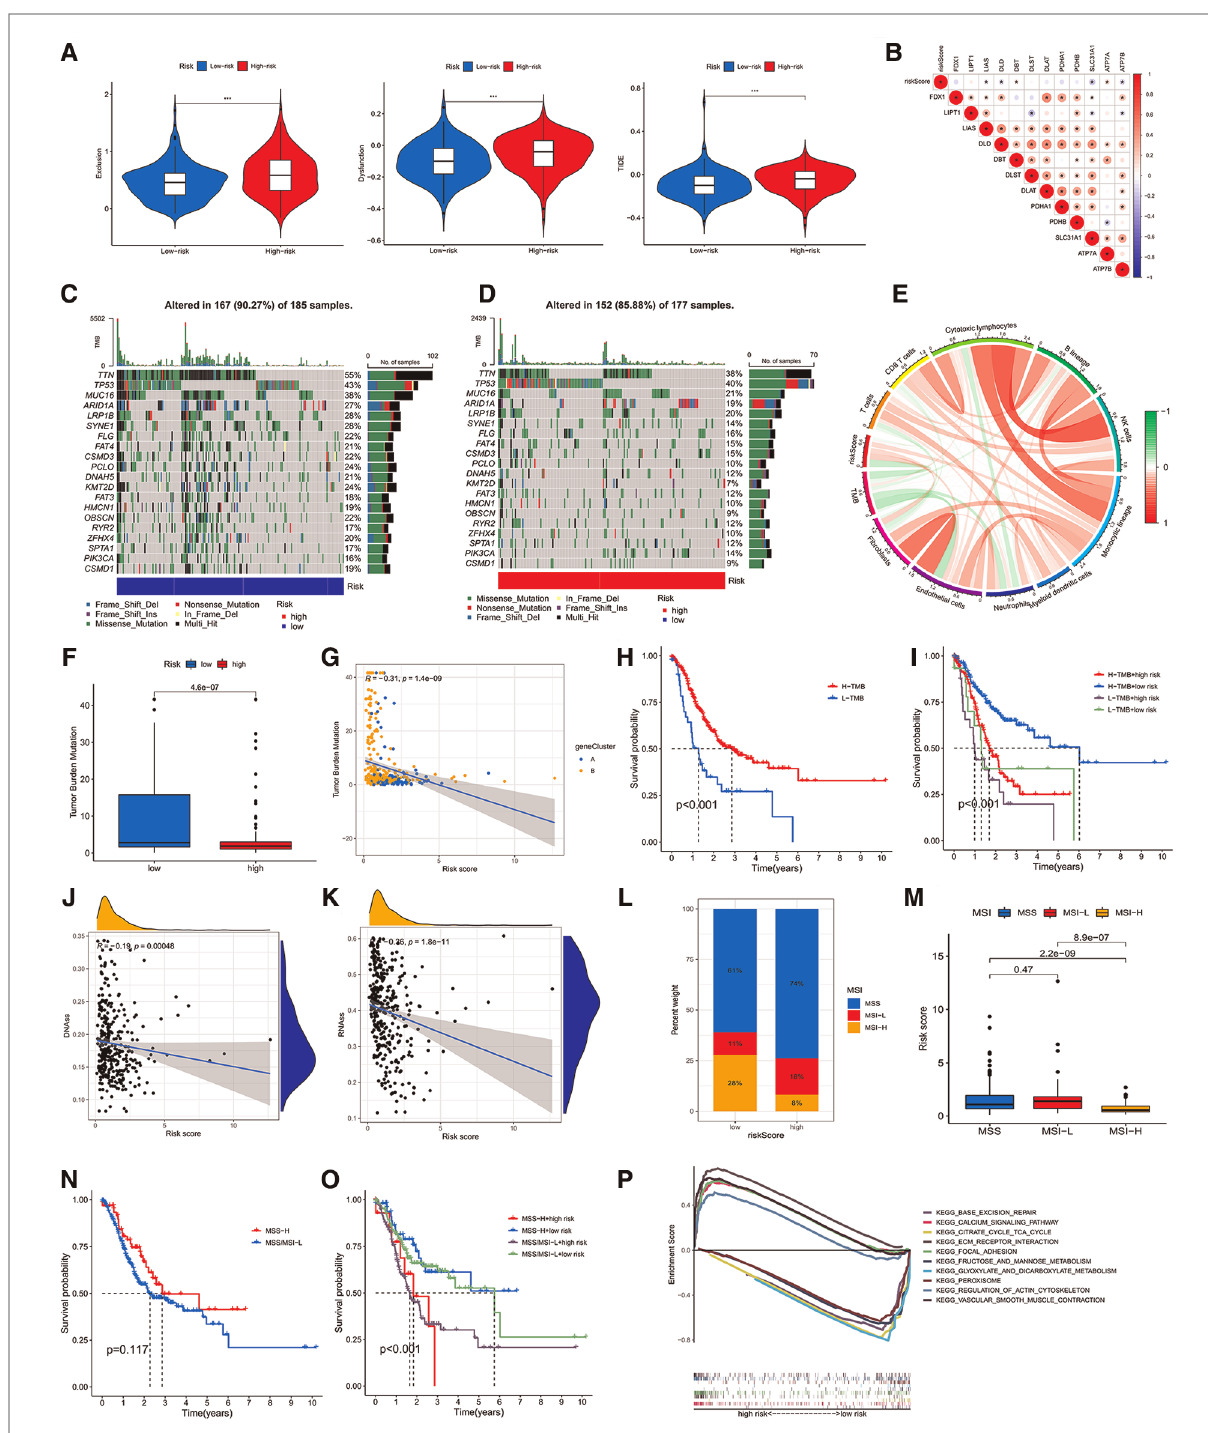
FIGURE 8 ( A ) associations of the TIDE score and the two risk groups. ( B ) Correlative analysis between risk score and expression of CRGs. Waterfall chart showing the top 20 mutated genes and their frequencies in the low-risk group ( C ) and the high-risk group ( D ). ( E ) Circle graph showing the relationship between TMB, immune cells and risk score. ( F ) The diagram showing the levels of TMB in the two risk groups. ( G ) Correlative analysis between risk score and expression of TMB. ( H ) The survival analysis of the low- and high-TMB groups. ( I ) The survival analyses of combined TMB and risk groups. ( J,K ) Cancer stem cell (CSC) index analyses of riskscore. ( L,M ) Associative analysis between MSI and riskscore. ( H ) The survival curve of the MSS/MSI-L and MSI-H groups. ( O ) The survival analyses of combined MSI and risk groups. ( P ) The GSEA analysis of low- and high- CRG_score